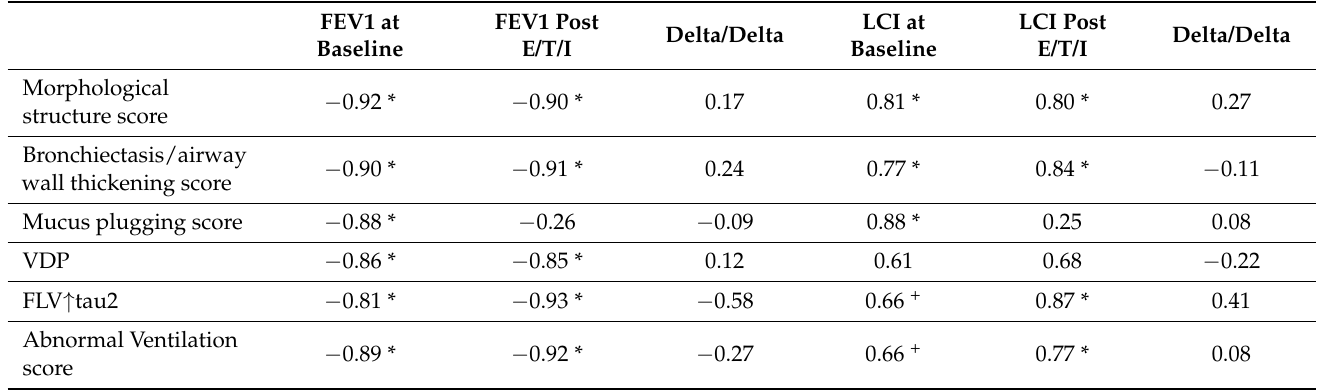
Table 5. Correlations between imaging endpoints and lung function measurements (FEV 1 and LCI) at each visit.